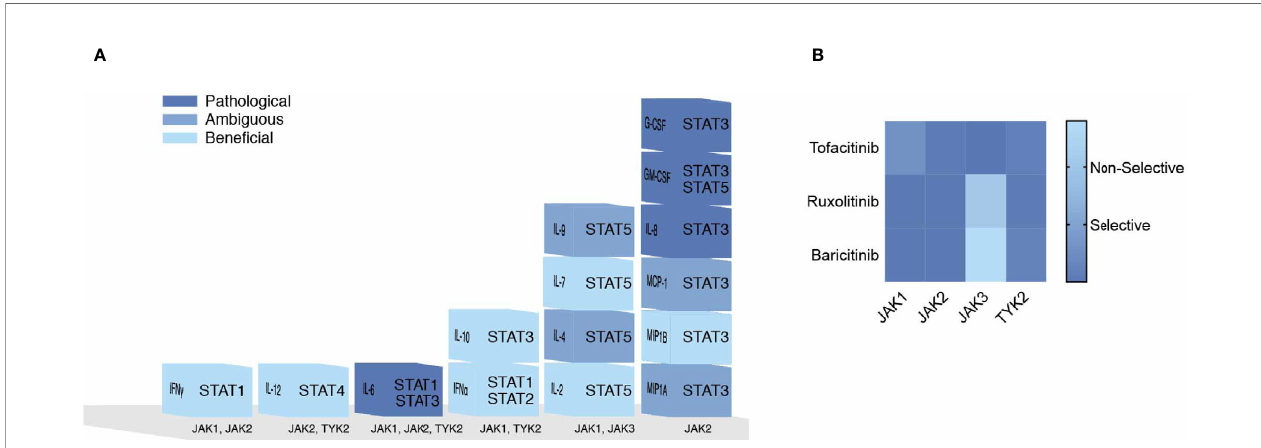
FIGURE 3 | Pathogenicity of the Cytokine Storm Driven by JAKs. (A) COVID-19 elevated cytokines directly signaling by the JAK-STAT pathway are shown in a heat map corresponding to their predicted pathogenicity in COVID-19 based on Table 1 . (B) JAK inhibitors are shown with their selectivity of each JAK based on their IC50